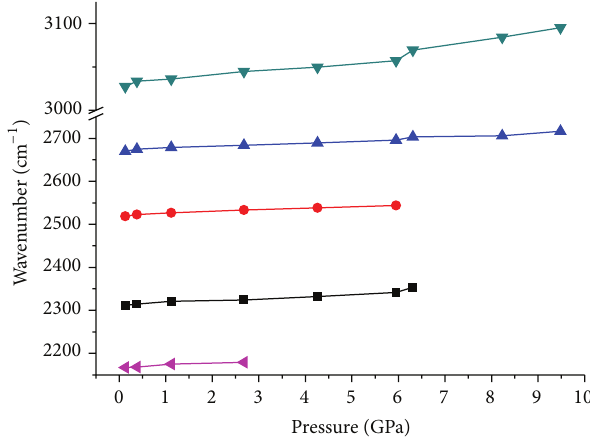
Figure 6: Pressure-induced Raman shift of various modes of canthaxanthin in the spectral region of 2100 cm −1 to 3200 cm −1